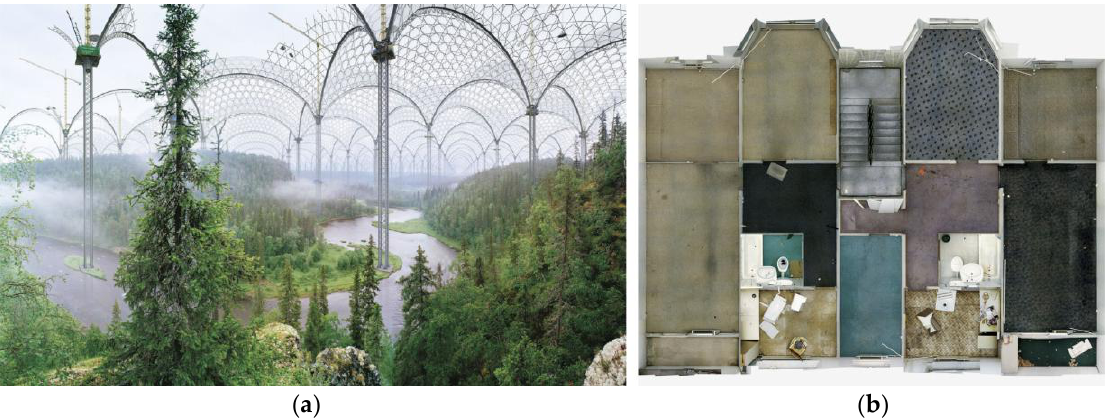
Figure 8. ( a ) Ilkka Halso, Museum of Nature, Kitka-river , 2004; ( b ) Andreas Gefeller, Plattenbau 4 ,